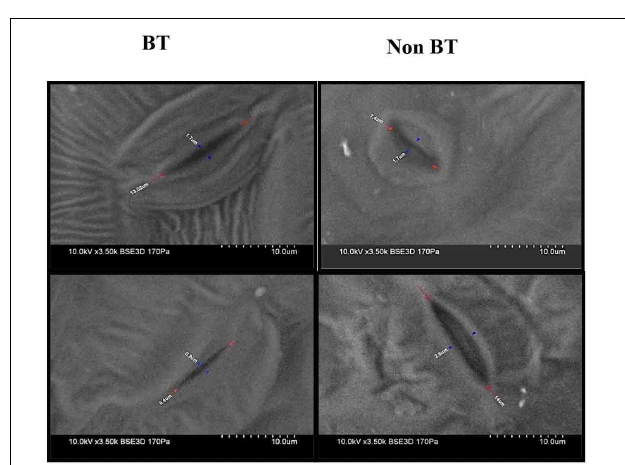
FIGURE 3 | Observations of leaf stomata under a scanning electron microscope of BT and Non-BT